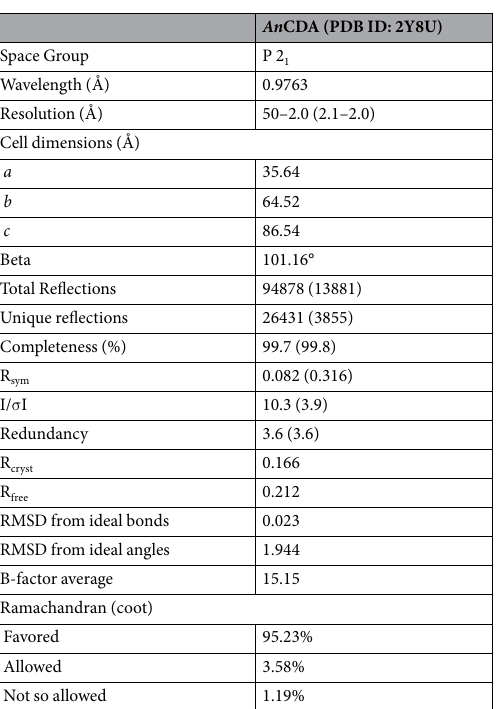
Table 2. Crystallographic data. Values in parentheses are for the highest resolution